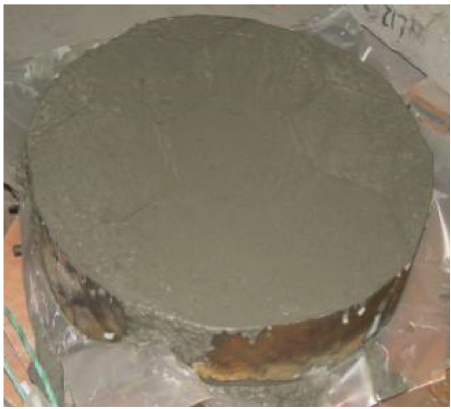
Figure 2: Honeycomb shelter target